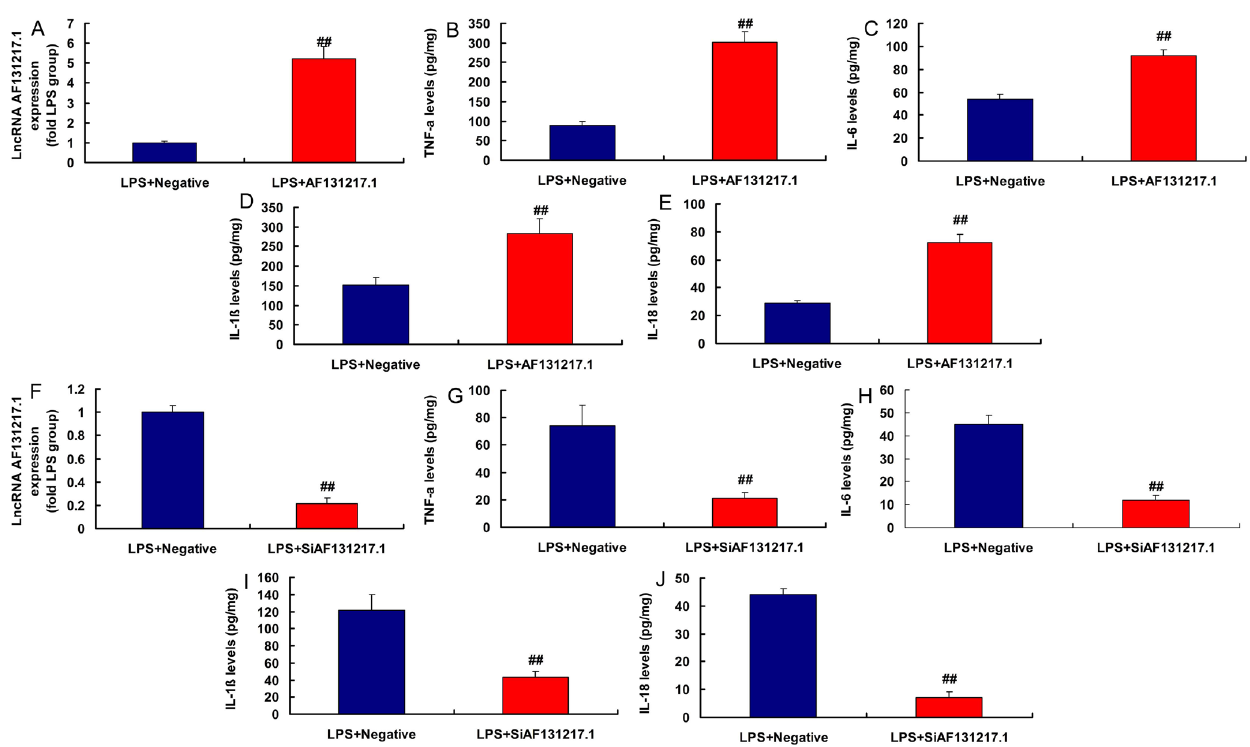
Fig. 2 - Long noncoding ribonucleic acid (lncRNA) AF131217.1 regulated inflammation in the in vitro model. LncRNA AF131217 expression (A), tumor necrosis factor alpha (TNF-α), interleukin (IL)-6, IL-1β, and IL-18 (B, C, D, and E) in overexpression of lncRNA AF131217 group; lncRNA AF131217 expression (F), TNF-α, IL-6, IL-1β, and IL-18 (G, H, I, and J) in downregulation of lncRNA AF131217 group. LPS+Negative, LPS- induced in vitro model by negative mimics group; LPS+AF131217.1, LPS-induced in vitro model by AF131217.1 group. ## P<0.01 compared with LPS+Negative group.